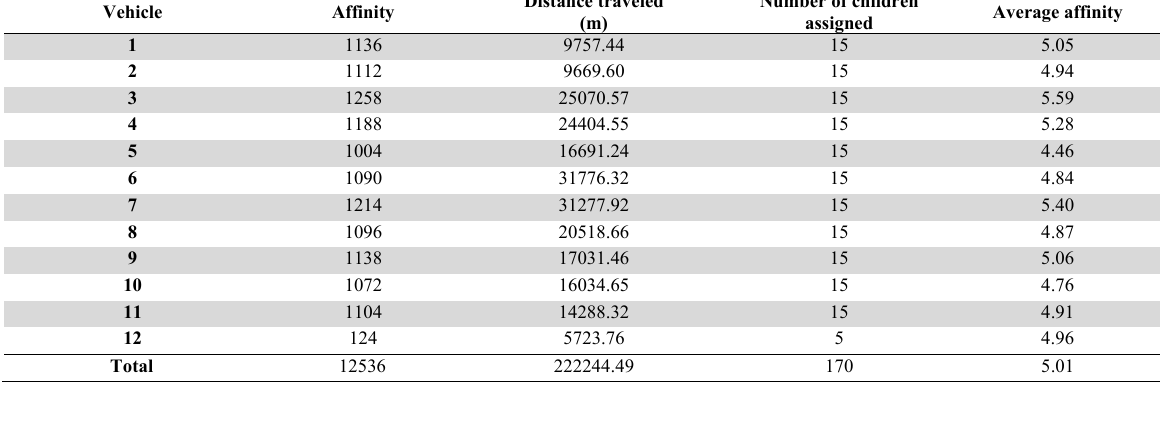
Indicators of the assignment of children with the multisweep algorithm